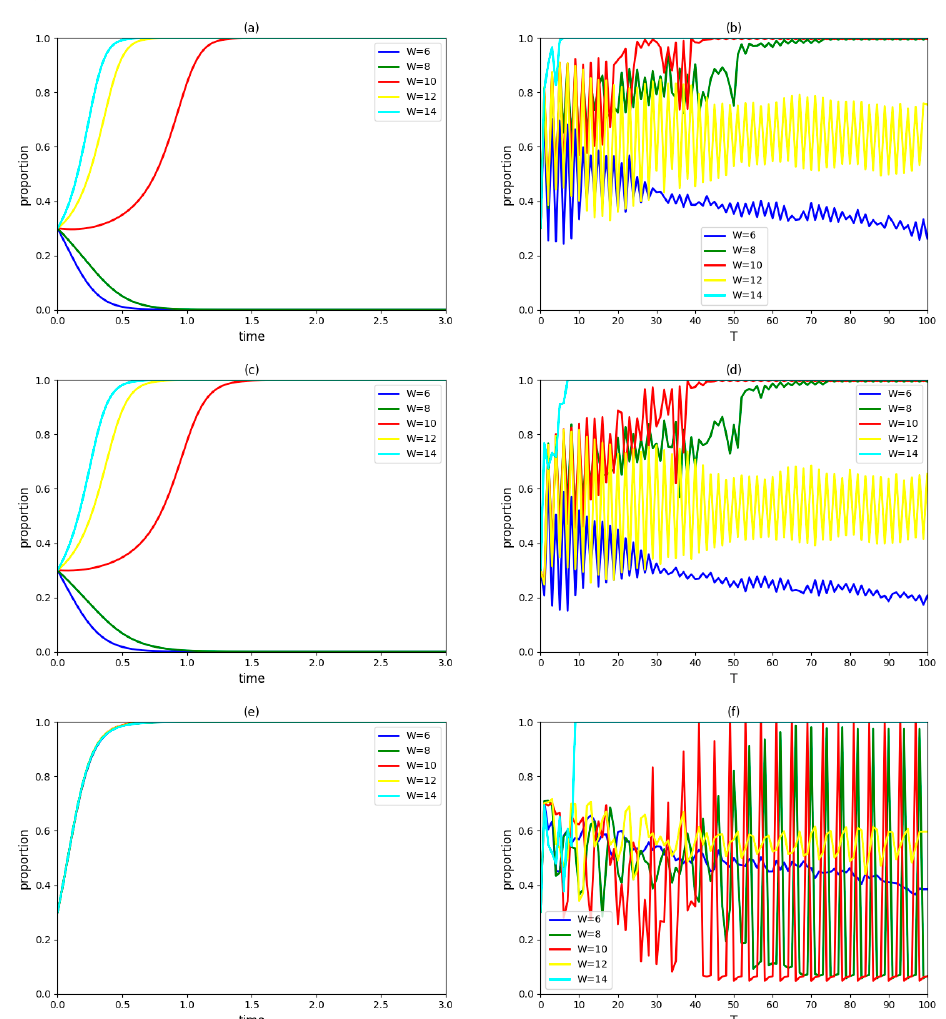
Figure 4. ( a ) The evolutionary paths of an enterprise strategies with different penalties for breaches of contract. ( b ) The proportion of cooperative enterprises in the region over time. ( c ) The evolutionary paths of a university/institute strategies with different penalties for breaches of contract. ( d ) The proportion of cooperative universities/institutes in the region over time. ( e ) The evolutionary paths of government strategies with different penalties for breaches of contract. ( f ) The implementation of the proportion of the government adopting a participation strategy in the region over time.